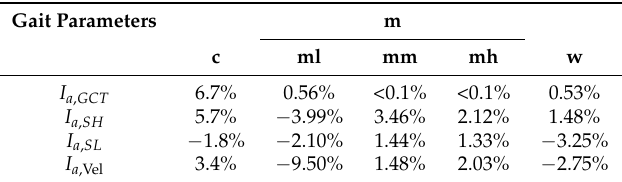
Table 7. Asymmetry indices for straight